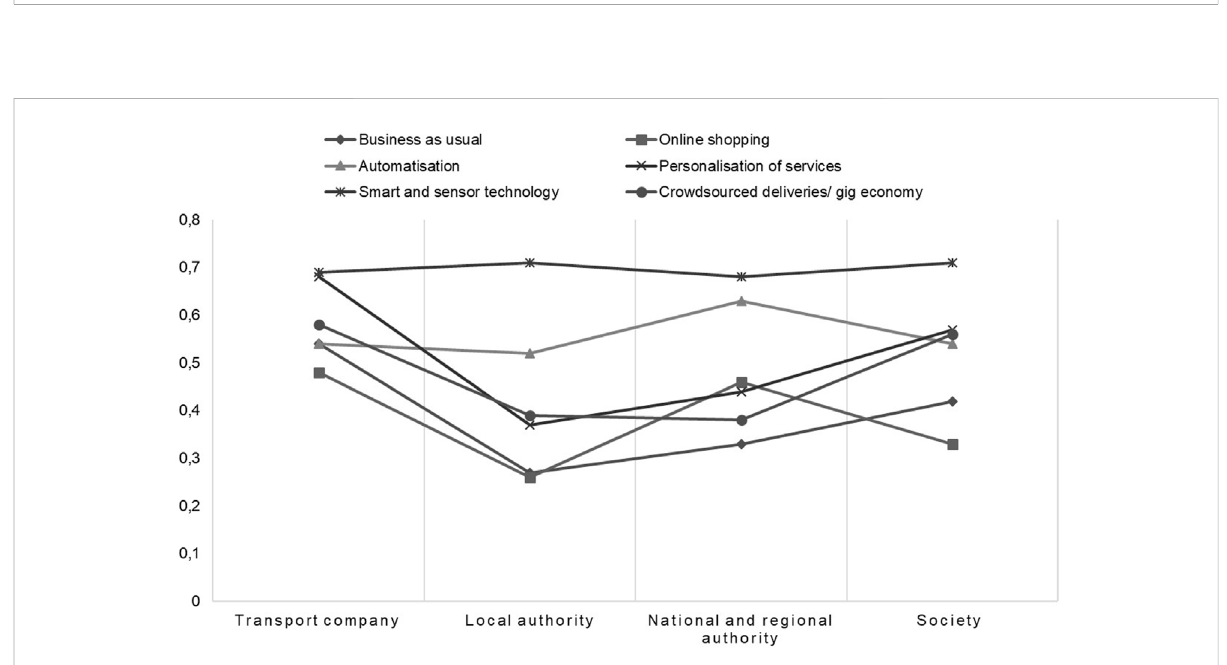
FIGURE 6 Overall modelling result from the workshop using the MAMCA modelling tool (Verlinde, 2020).